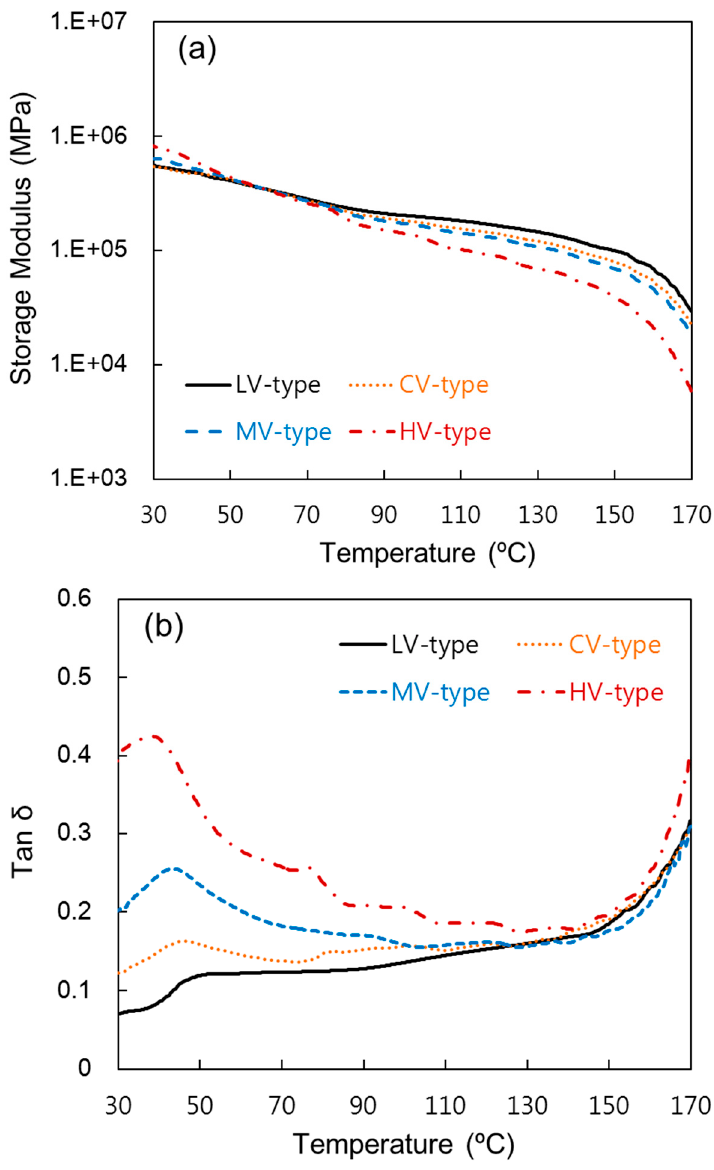
Figure 5. Dynamical mechanical thermal analysis (DMTA) of the composites produced at pressure rising time of 25 min. ( a ) Storage modulus; ( b ) loss factor (tan δ ).